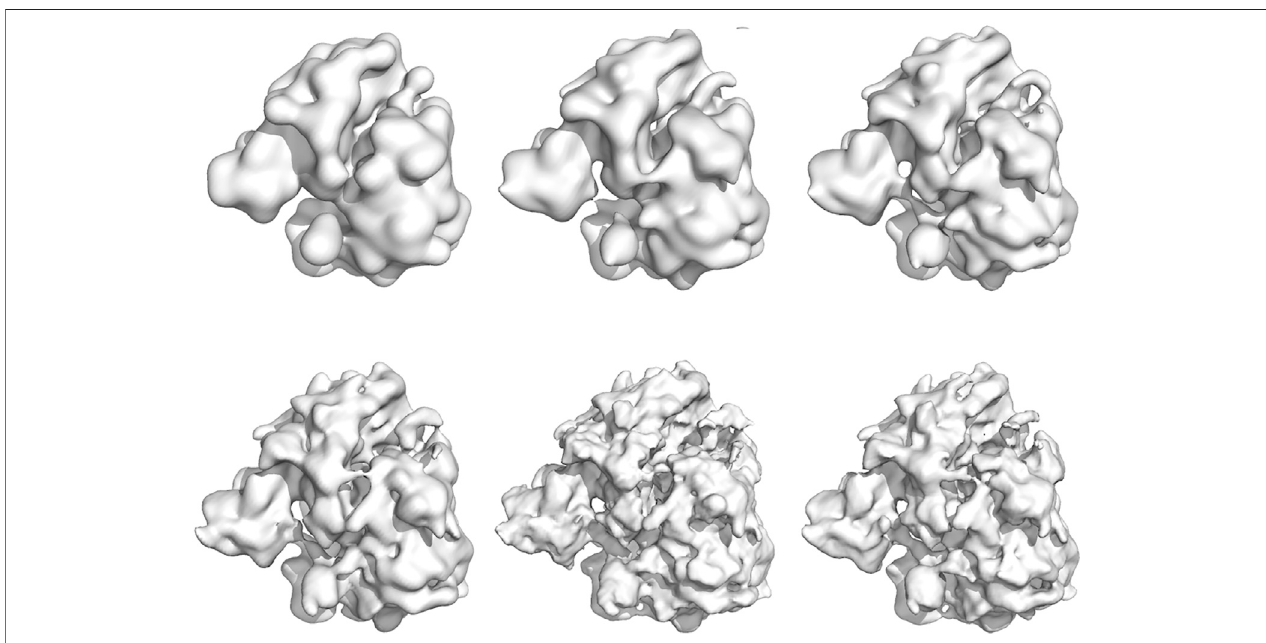
FIGURE7| Densitymapsofthe80SribosomeobtainedwithBayesianrandomtomographyusing50classaveragesasinput.Toprow:200,1,000,2000particles (left to right) . Bottom row: 4,000, 8,000, 12,000 particles (left to right) .